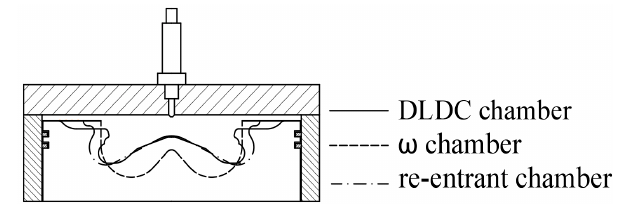
Figure 2. Profile comparison of different chambers.